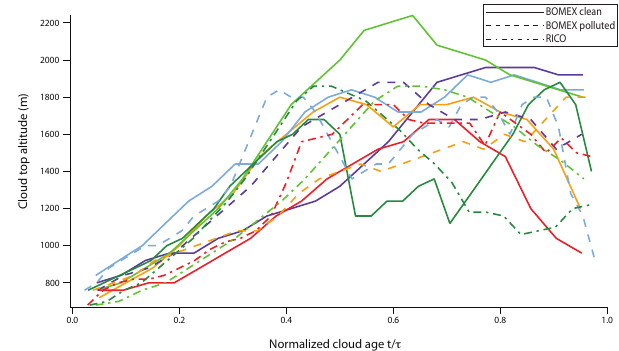
Figure 7. Time series of cloud top altitude.